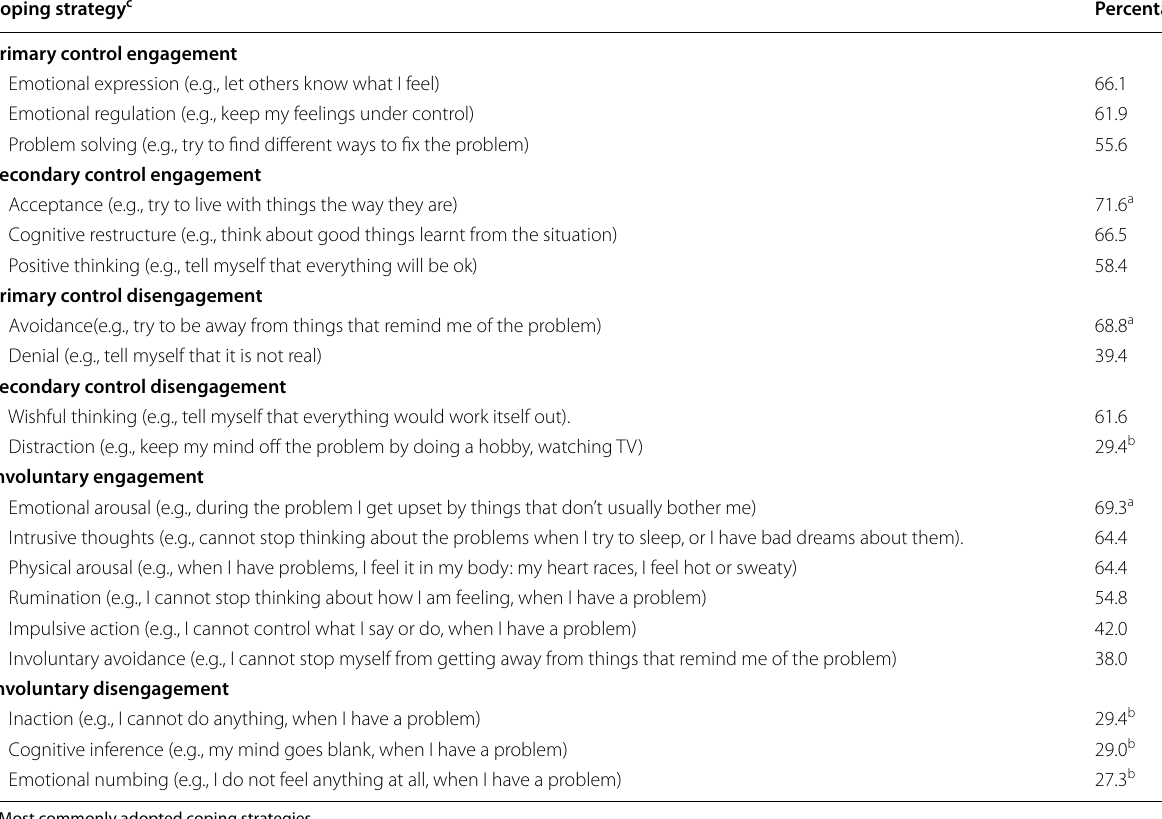
Table 3 Coping strategies adopted by mothers of diabetic